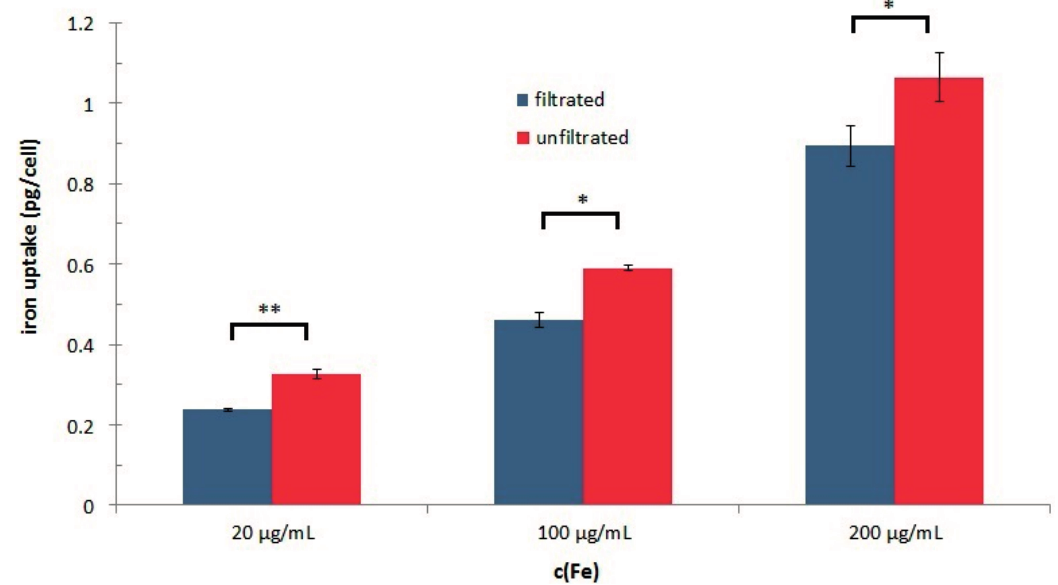
Figure 7. Influence of tangential ultrafiltration on cellular uptake of SEON LA-BSA . Total iron oxide concentration of filtrated (blue bars) and un-filtrated (red bars) SEON LA-BSA in Jurkat cells after 48 h of incubation. The uptake was significantly reduced by filtration for all three concentrations tested (* p < 0.05; ** p < 0.005). All measurements were performed in triplicate; the background was